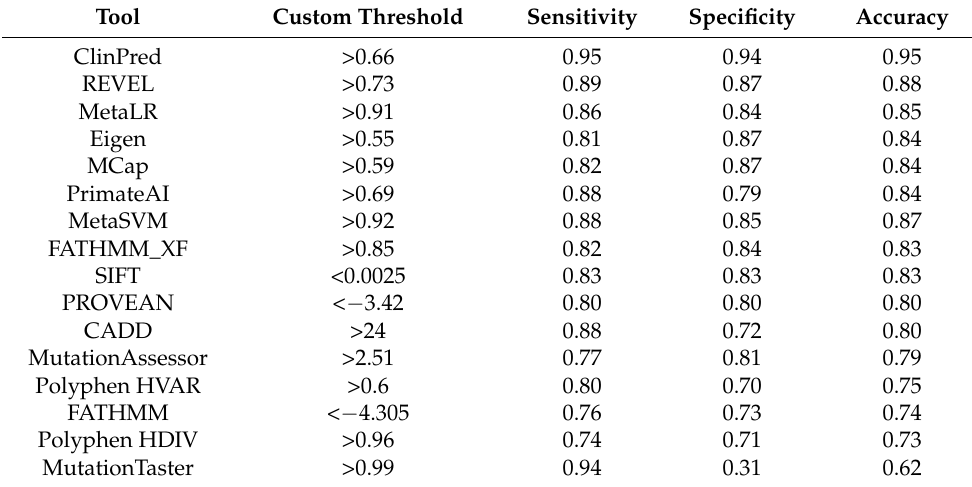
Table 2. Performance of variant interpretation